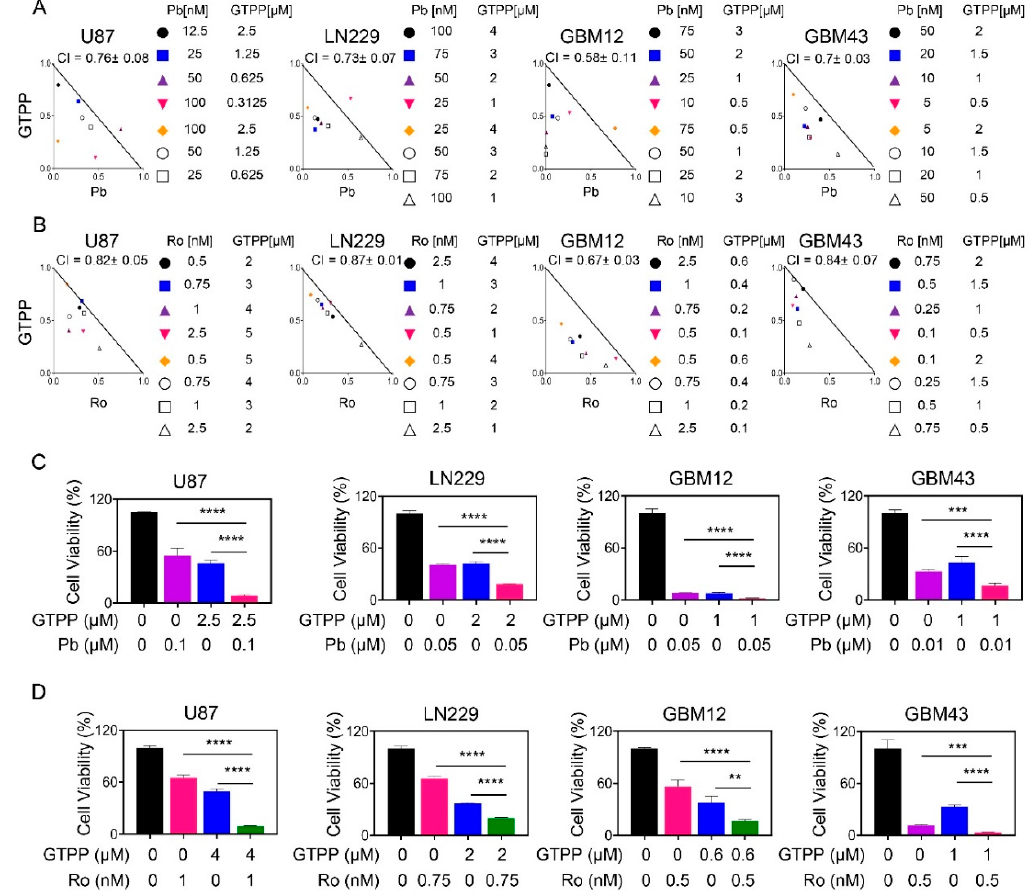
Figure 1. Combined treatment with gamitrinib and histone deacetylase (HDAC) inhibitors elicits synergistic reduction in cellular proliferation of glioblastoma (GBM) cells. ( A , B ) U87, LN229, GBM12 and GBM43 cells were treated with gamitrinib (GTPP), panobinostat (Pb)/romidepsin (Ro) or the combination of GTPP and panobinostat/romidepsin for 72h. Thereafter, cellular viability and statistical analysis were performed. Isobolograms are shown; ( C , D ) The graphs show cellular viability data following treatment with vehicle, panobinostat/romidepsin, gamitrinib or the combination for 72h in the indicated GBM cells ( n = 3, 4). Shown are means and SD. ANOVA was used for statistical analysis. ** p < 0.01, ***/**** p < 0.001.